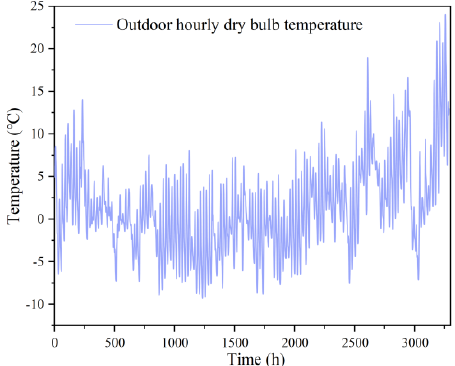
Figure 1. Hourly outdoor temperature